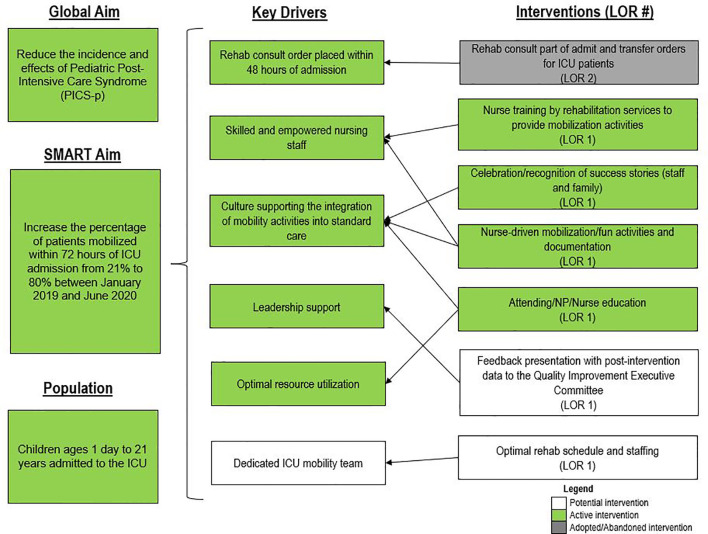
Key driver diagram targeting early mobility of intensive care unit (ICU) patients. LOR, level of reliability; NP, nurse practitioner.